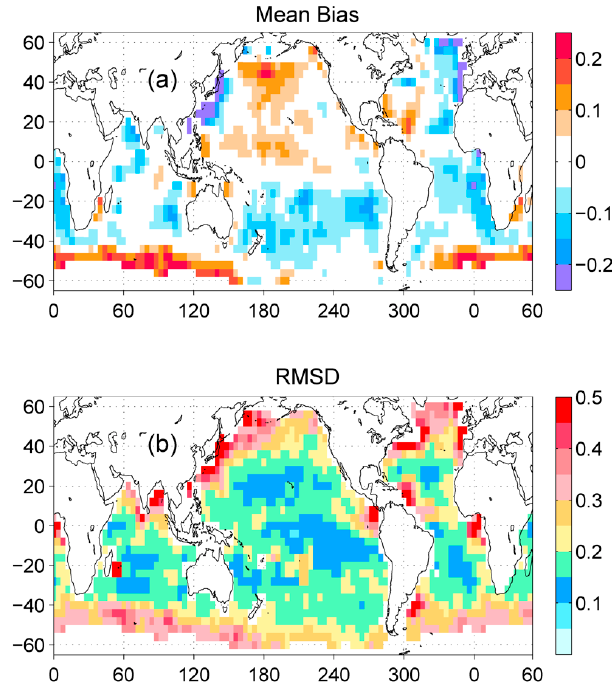
Figure 3. Geographical distribution of ( a ) mean spatial bias (psu), and ( b ) root-mean-square deviation (RMSD) (psu) between the Aquarius weekly Level-3 SSS product and Argo float observations. The error statistics were computed by comparing Argo float measurements for a given week with SSS values at the same locations obtained by interpolation of the corresponding Level-3 SSS maps. The geographical distributions are computed in 8°-longitude by 8°-latitude bins.